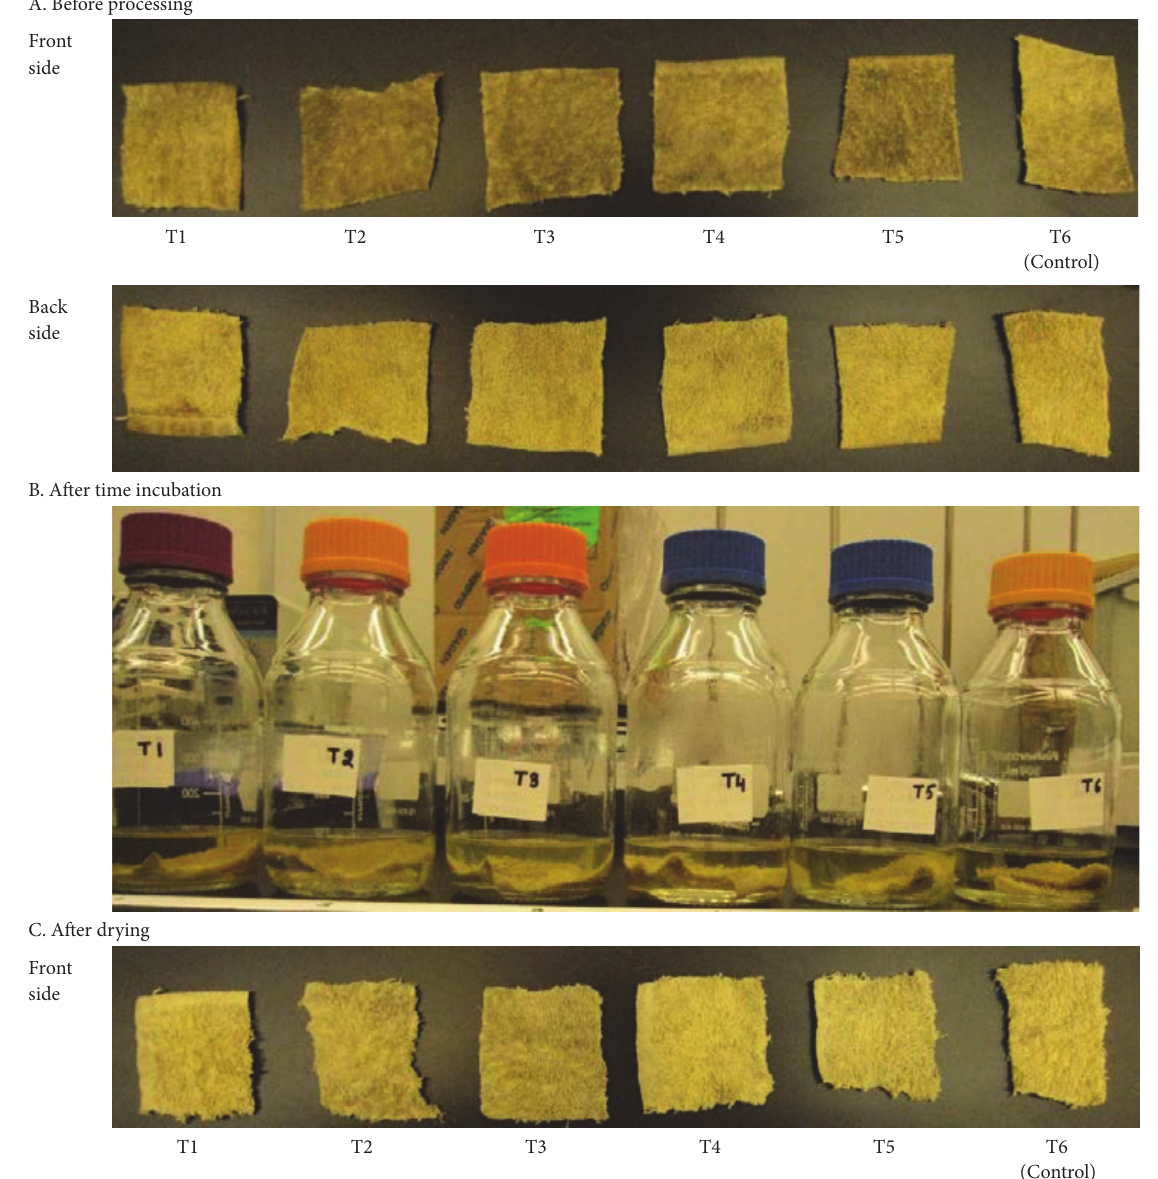
Figure 4: Visual views of cloth samples processed with modified EHOs formulations (with pH adjustment). Note: An alphabetical integer value represents compositions of different detergent formulation as listed in Table